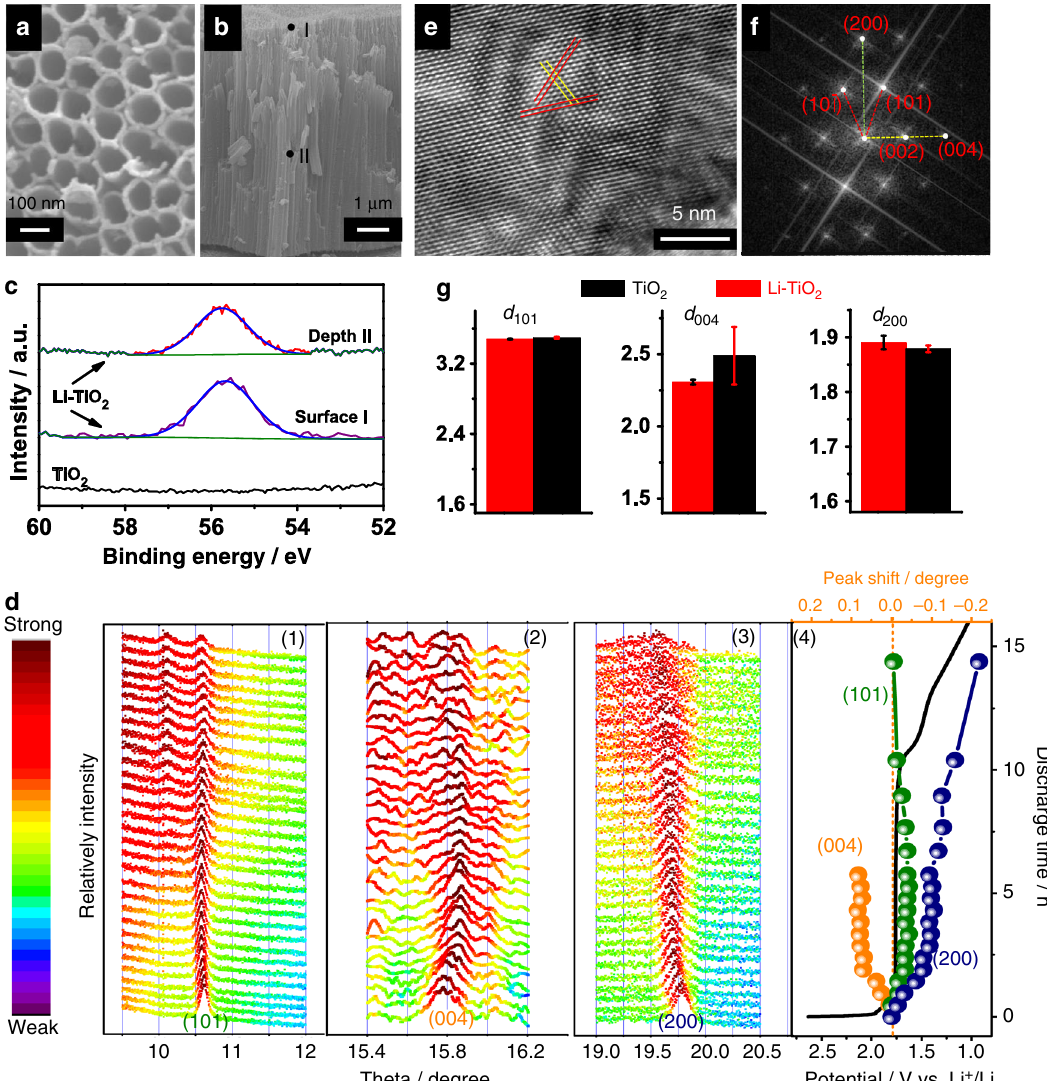
Fig. 3 The structure change of TiO2 upon the lithiation. a , b The top-view and cross-section view SEM images of Li-TiO 2 electrode. c XPS spectra of Li 1 s recorded from the top surface of TiO 2 and Li-TiO 2 . The signal from the exposed bulk (marked point II in b ) of Li-TiO 2 was also recorded. d Evolution of in- situ XRD patterns of TiO 2 at the discharging process in LIBs (black curve in (4)). Three peaks (1) (101), (2) (004), and (3) (200) are traced. The peak shifts referred to the ones at initial peaks are summarized in (4). e , f A typical HR-TEM image of Li-TiO 2 and its corresponding FFT image. g Comparison of the lattice distances along [101], [004], and [200] for (black) TiO 2 and (red) Li-TiO 2